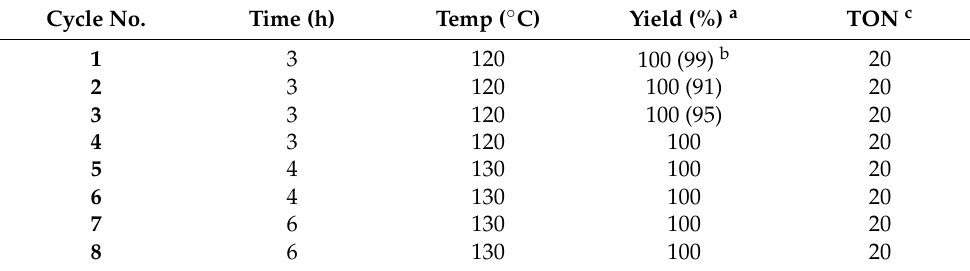
Table 1. Recycling results of 2a -catalyzed Stille reaction of iodobenzene ( 4 ) and vinyl tributyltin ( 3 ) under the thermomorphic mode.